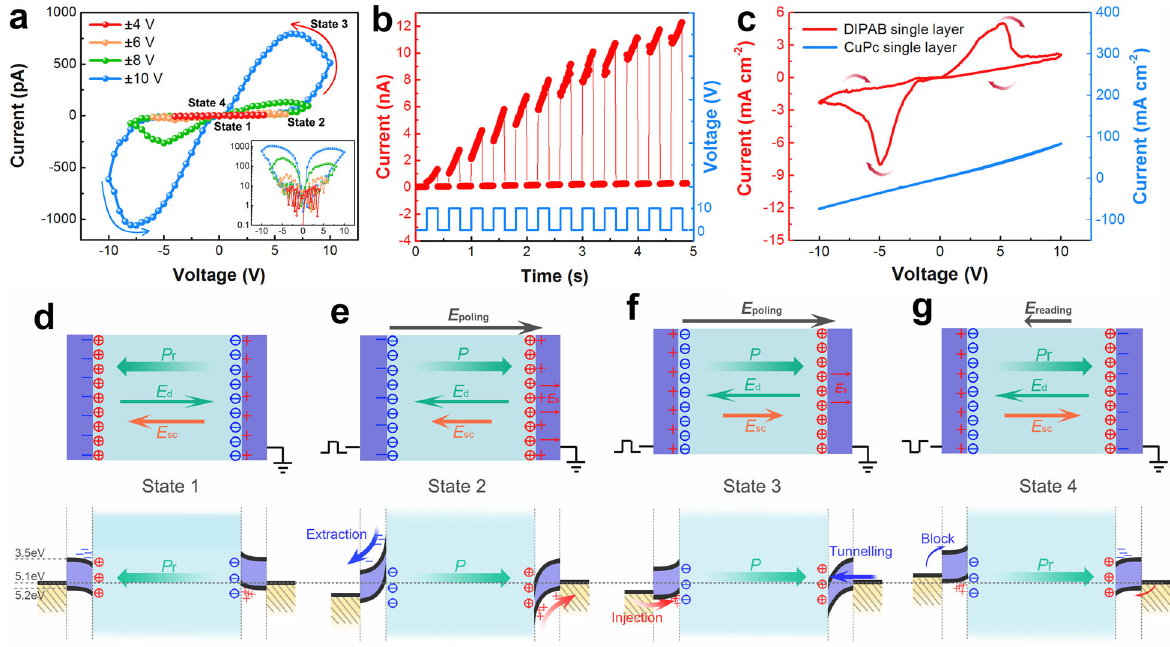
Fig. 3 Electrical characterizations of the MF/CuPc interfaces. a Memristive behavior with voltage sweep ranges exceeding 5 V, which can also be plotted as the inset in a semi-log scale. b The current response to the series of 10 V pulses with a duration of 400 ms. c I-V curves of single DIPAB and CuPc devices with the same device structure. d Initial state of the MF/CuPc interfaces after poling by a negative electric fi eld E < – E 50 – 52 . e and f Intermediate states in response to a positive poling c . The values of the energy levels for the materials are from literatures fi cation effect of the MF layer can induce large stray fi elds in the right CuPc interlayer. Electron injection for fi eld E > E c . The ampli compensation occurs due to the large stray fi elds inside the CuPc. g Final state, which was then read by a negative fi eld < E c